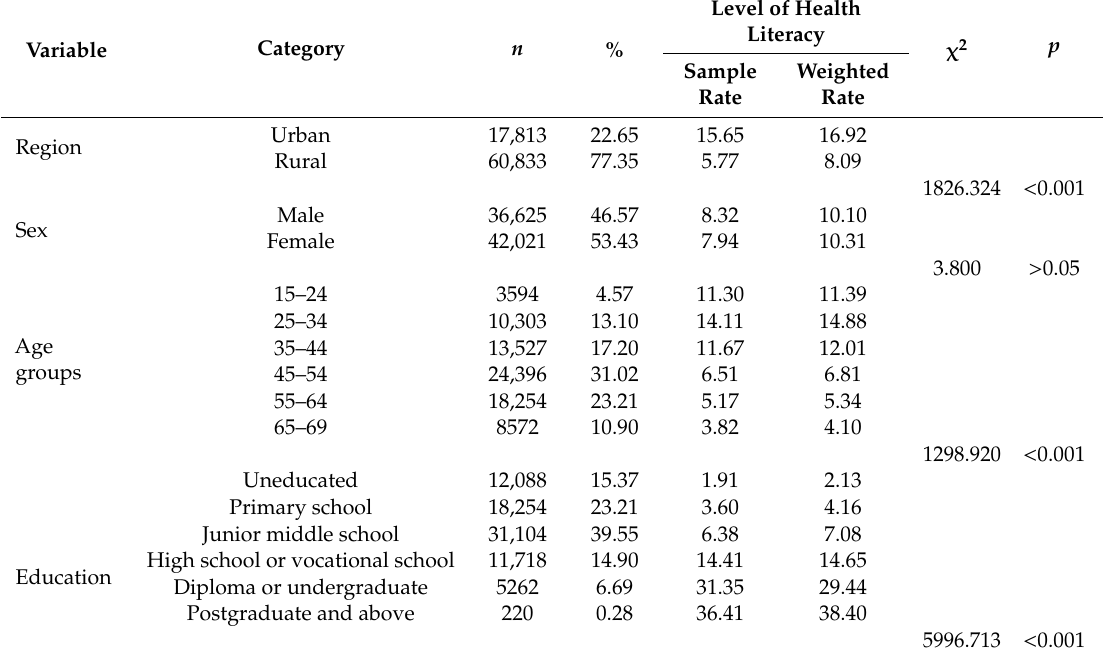
Table 1. Sample characteristics and level of health literacy in the participants ( n =